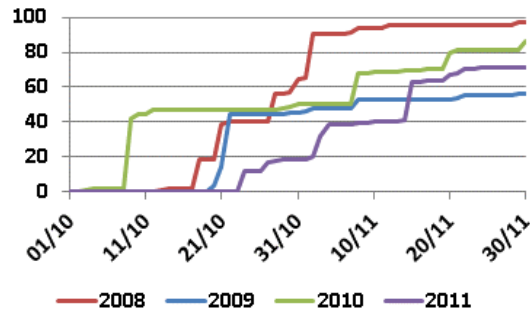
Figure 2. Accumulated precipitation in October and November after the records of the weather station of Sodeto,